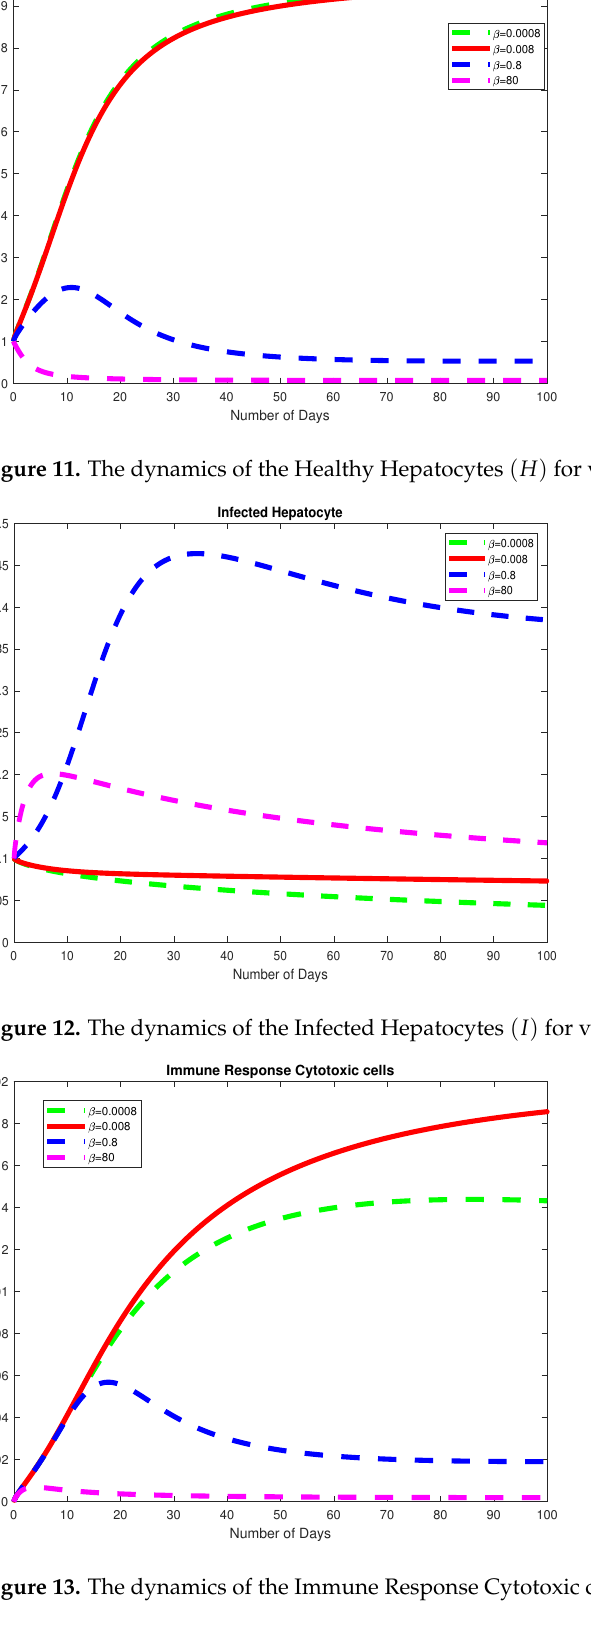
Figure 13. The dynamics of the Immune Response Cytotoxic cells ( R ) for varying values of β